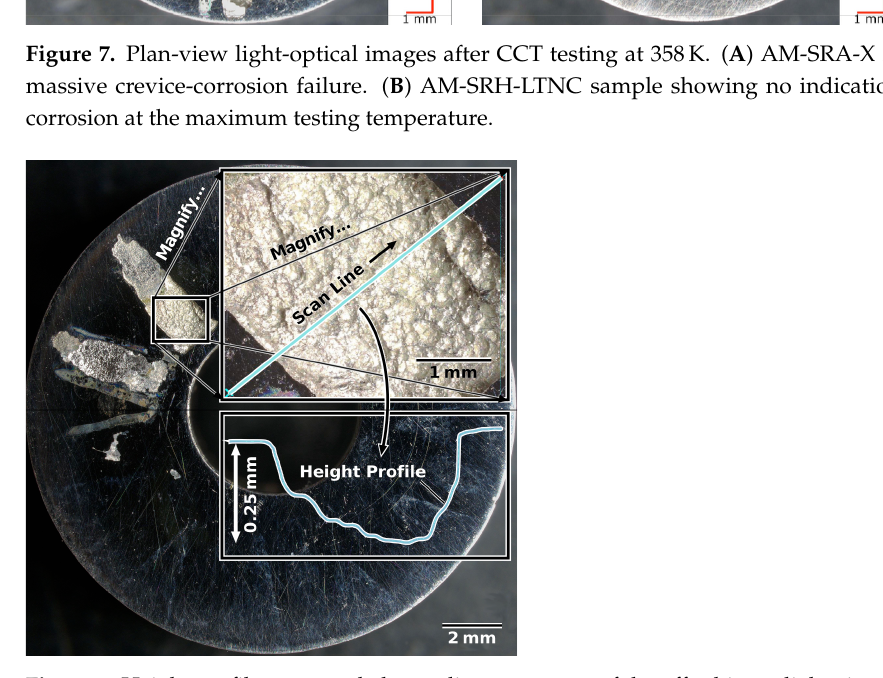
Figure 8. Height profile measured along a line across one of the off-white radial stripes visible after CCT testing of a non-treated sample (AM-SRH-X) at